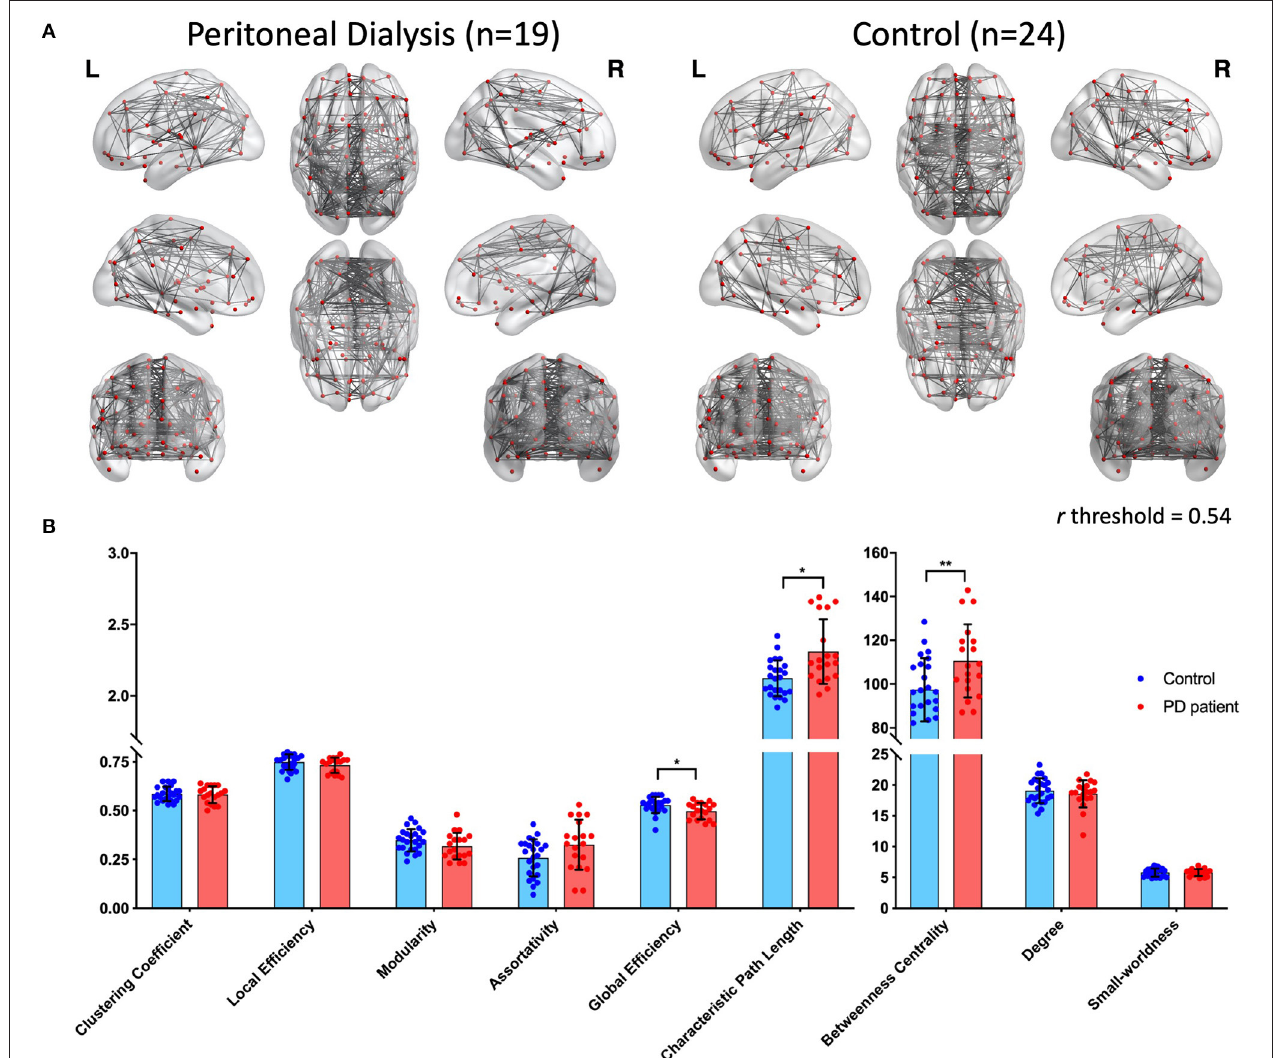
FIGURE 1 | (A) Whole-brain connections by graph analysis of patients receiving peritoneal dialysis (left) and controls (right) (density = 0.2). Nodes were chosen from the 90 regions in the automated anatomical labeling (AAL) template, and the edges are shown under the condition of a threshold above 0.54. (B) Distributions of nine parameters from graph analysis. Blue dots represent controls, and red dots represent patients with PD. The columns and error bars represent the means and SD, respectively. There are significant differences between the two groups in global efficiency, characteristic path length, and betweenness centrality. PD, peritoneal dialysis; * p < 0.05; ** p <